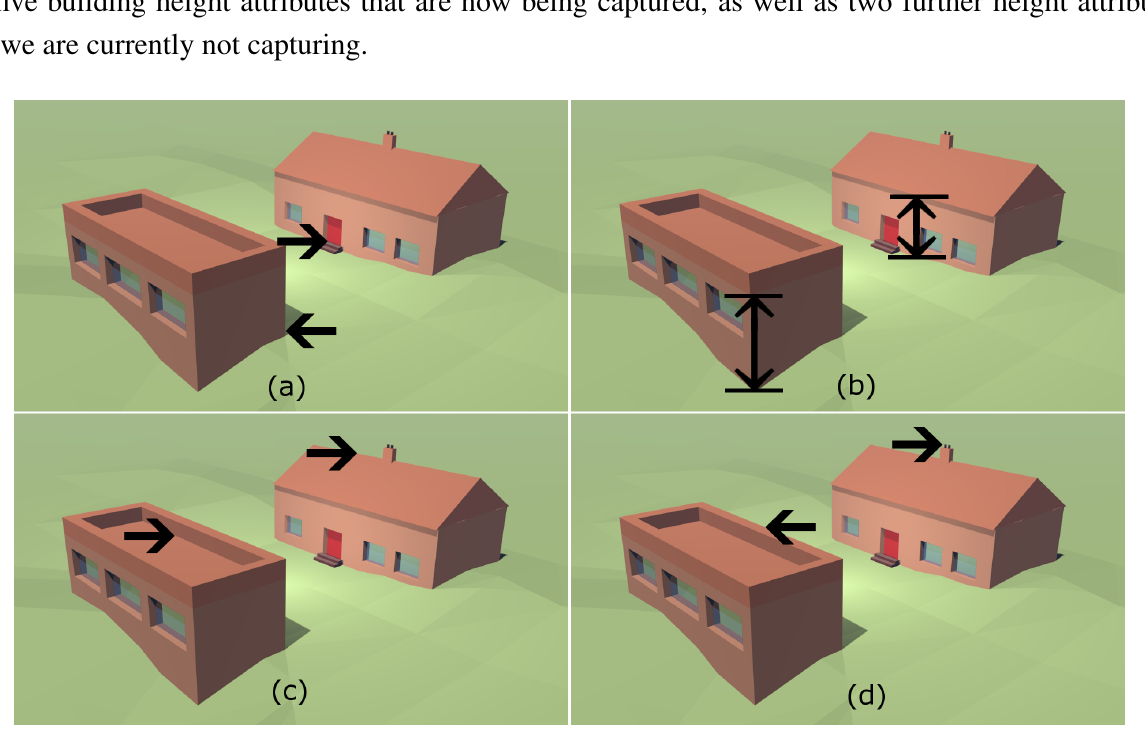
Figure 1. This figure uses synthetic 3D building models for illustrations of the building height characteristics of 3D